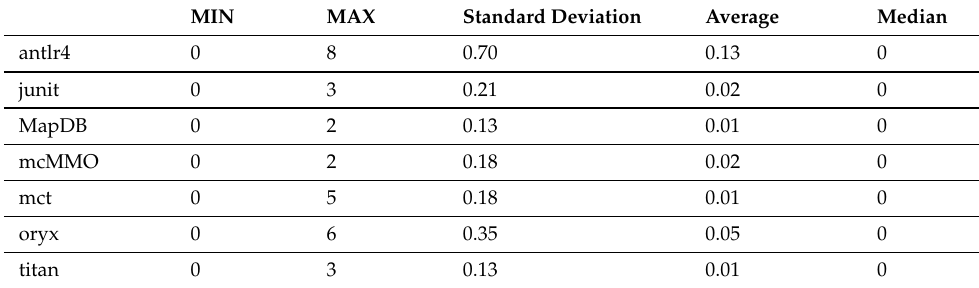
Table 4. Descriptive statistics of Refact_Sum.